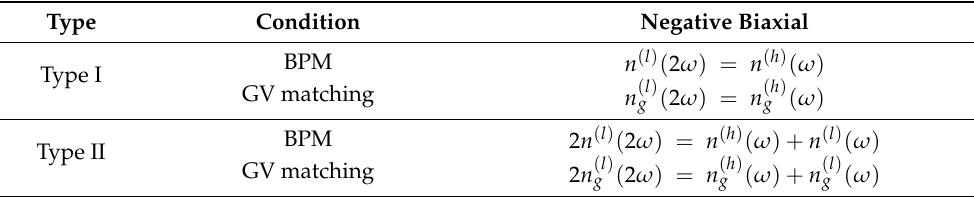
Table 3. The BPM and GV matching conditions for broadband SHG in biaxial crystals.